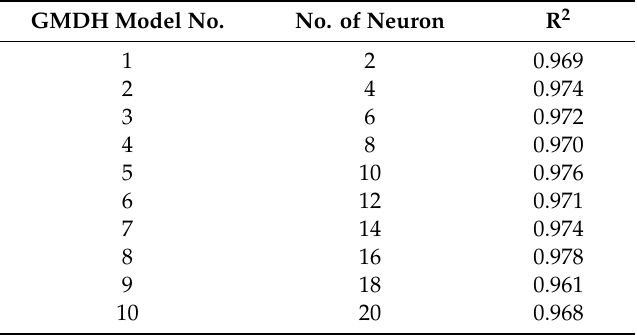
Table 4. The results of parametric study on the number of neurons.